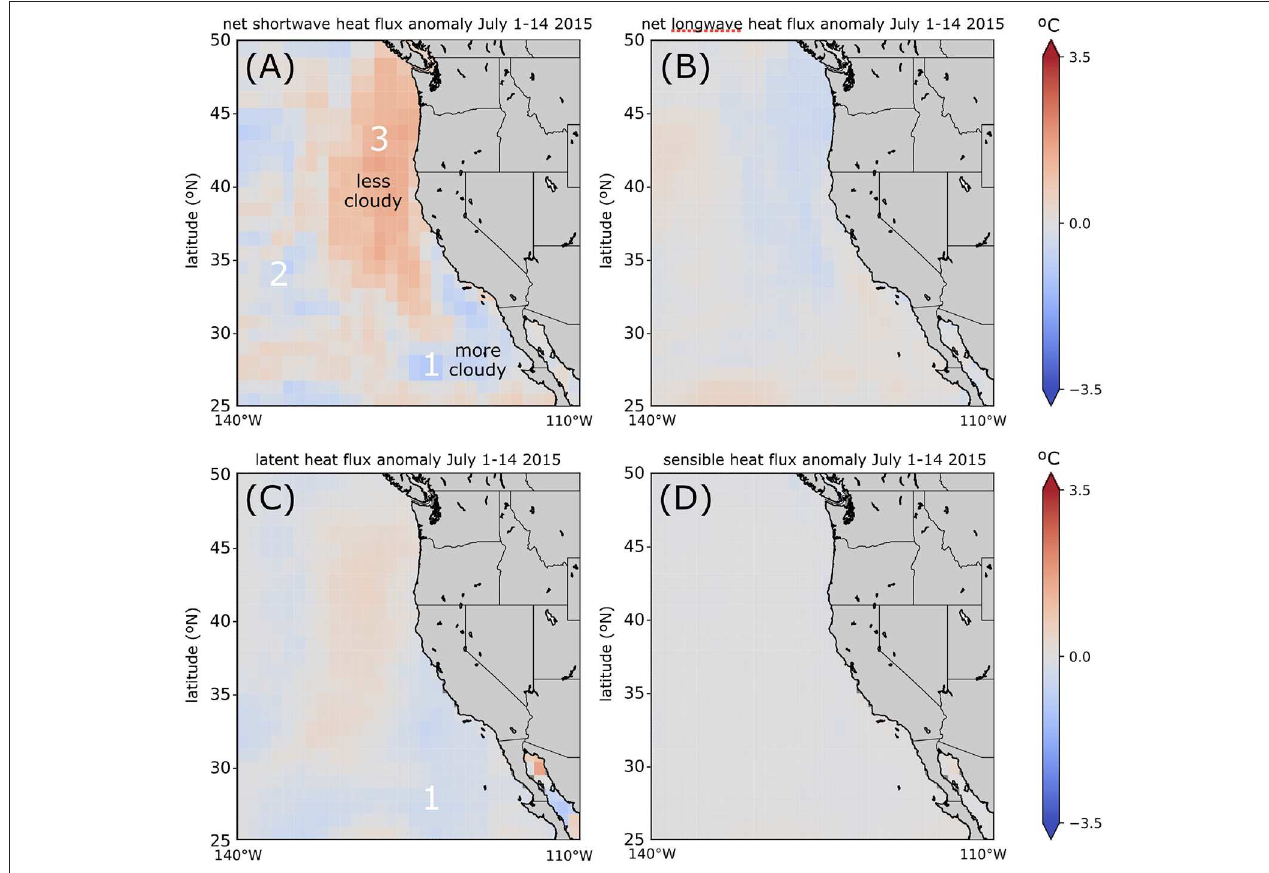
FIGURE 5 | Components of the net air-sea heat flux anomaly in the time-integrated 1-D budget during 1–14 July 2015 ( Figure 4B ). Positive indicates anomalous ocean warming (or equivalently, weaker cooling than in the climatology). The panels show accumulated anomalies in (A) net shortwave radiation, (B) net longwave radiation, (C) latent heat flux, and (D) sensible (conductive) heat flux. To facilitate comparison with Figure 4 , the heat flux anomalies have again been converted to the change in SST that would be generated for a climatological mixed layer depth of 20 m, following Flynn et al. (2017) (i.e., each heat flux is scaled by ρ 0 c p h with ∼ h 20 m). The color scale is the same for all panels. White numbers mark regions referred to in section =